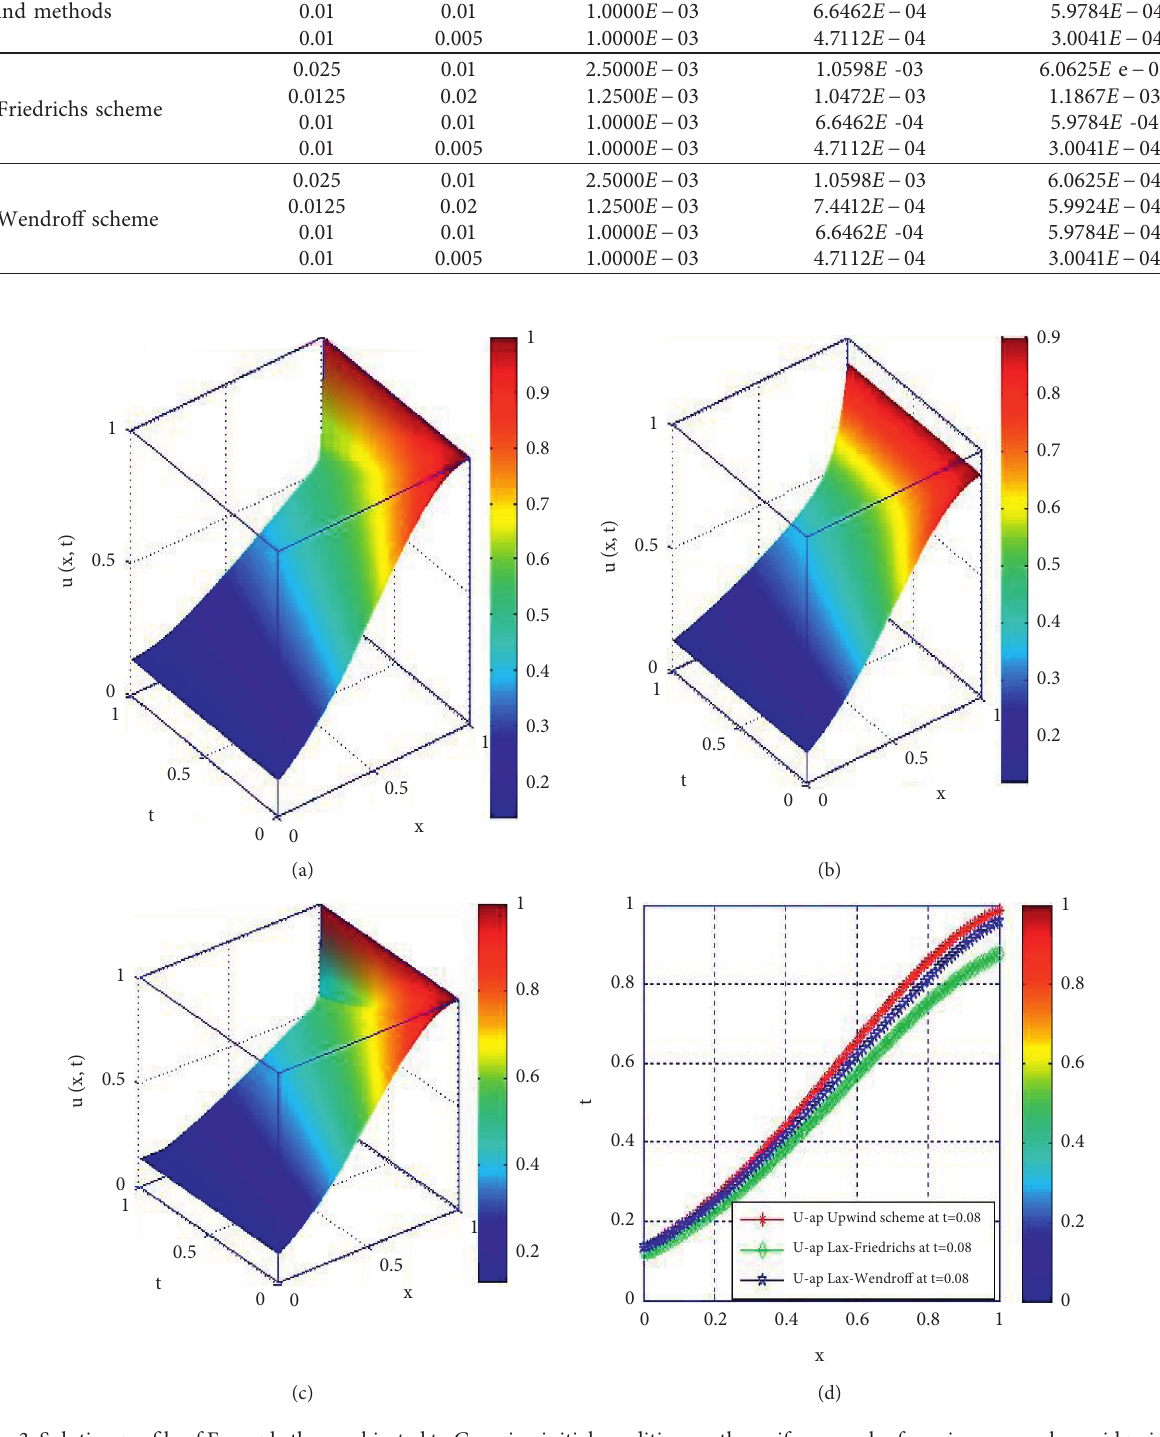
Figure 3: Solution profile of Example three subjected to Gaussian initial condition on the uniform mesh of maximum number grid point is Mx � 100 & time step is Δ t � 0 . 001. (a) Profile of solution obtained by Upwind scheme; (b) profile of solution obtained by Lax-Friedrichs scheme; (c) profile of solution obtained by Lax-Wendroff scheme; (d) comparison of numerical solution at the selected